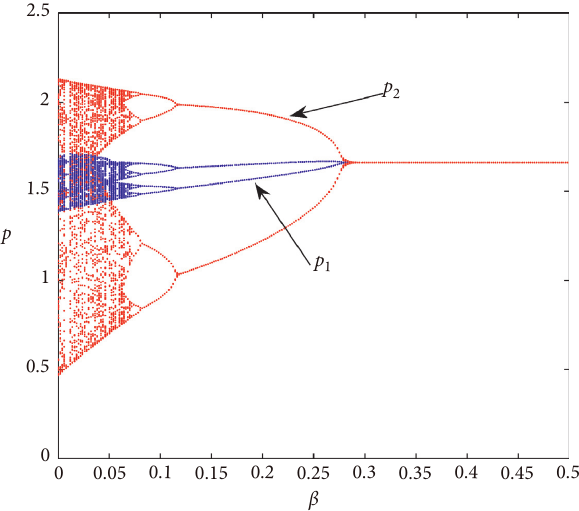
Figure 8: Control factor and price bifurcation.